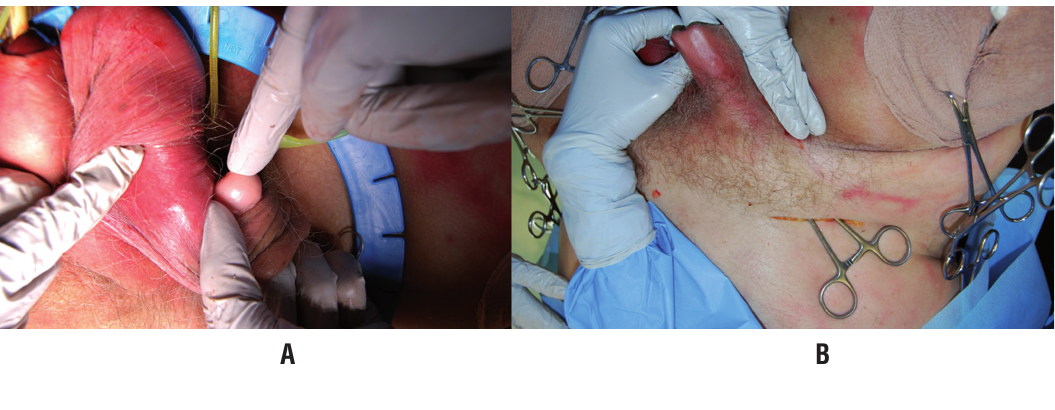
Figure 1 - A) Standard pump placement through counter incision B) Pump placement into sub-dartos pouch through perineal incision into the same space.